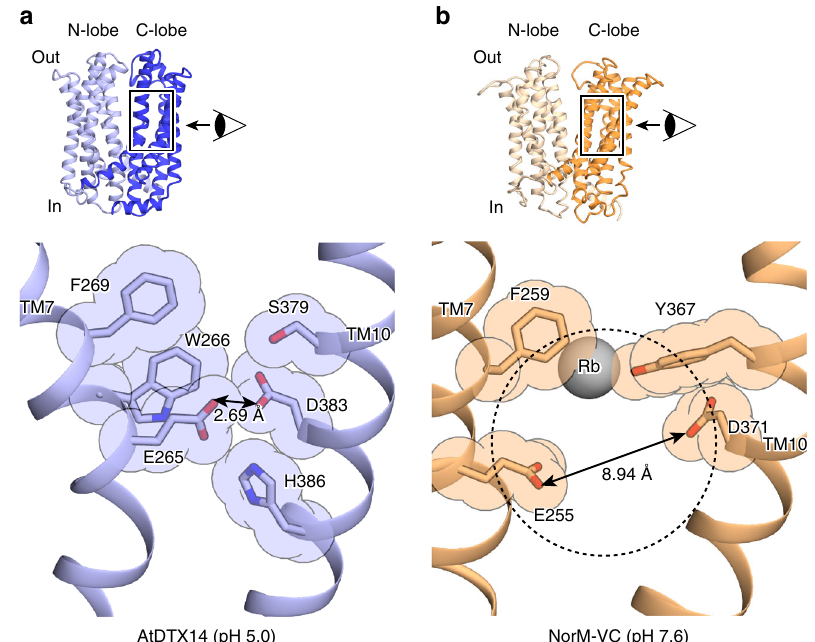
Fig. 7 Structural comparison of the C-lobes of AtDTX14 and NorM-VC. a , b Close-up views of the putative substrate pocket of AtDTX14 ( a ) and that of NorM-VC ( b ) located at the C-lobe. The gray sphere represents a rubidium ion, and the dashed circle indicates the putative substrate pocket of NorM-VC. The double-headed arrows indicate the distances between the glutamate and aspartate residues, which are essential for the transport activity and